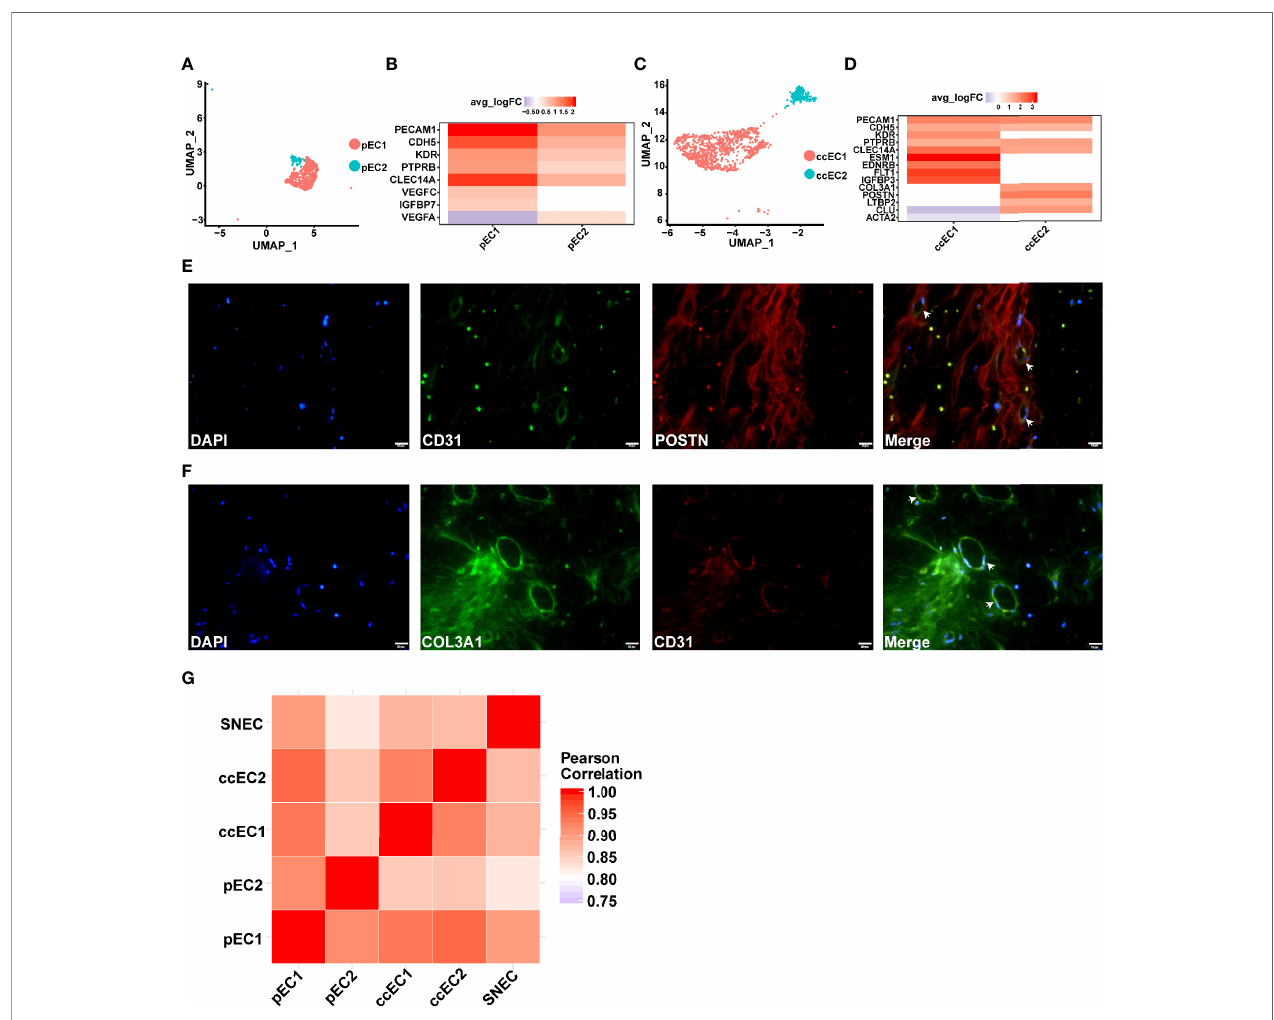
FIGURE 7 | scRNA-seq revealed two subpopulations of ECs in pRCC and ccRCC. (A – D) Two types of endothelial cells discovered in type 2 pRCC and ccRCC, respectively. (A) UMAP plot representation of two types of ECs in type 2 pRCC. (B) DEGs of two types of ECs in type 2 pRCC. (C) UMAP plot representation of two types of ECs in ccRCC. (D) DEGs of two types of ECs in ccRCC. A novel EC type (POSTN+ and COL3A1+) was identi fi ed. (E) IF analysis of the expression of CD31 (green), which is an EC marker, in combination with POSTN (red) and DNA staining using DAPI (blue) within the tissue paraf fi n sections from ccRCC to verify these novel ECs. (F) Another marker, COL3A1 (green), used to verify the same result. Scale bars, 20 mm. (G) Heat map indicating Pearson correlation coef fi cient on the average gene expression amongst EC population in type 2 pRCC, ccRCC and